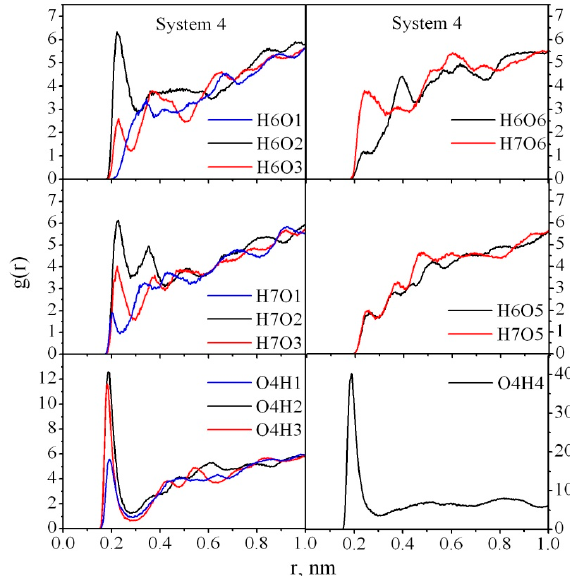
Figure 9. Atom–atom radial distribution functions for PAM–CNC in System 4.